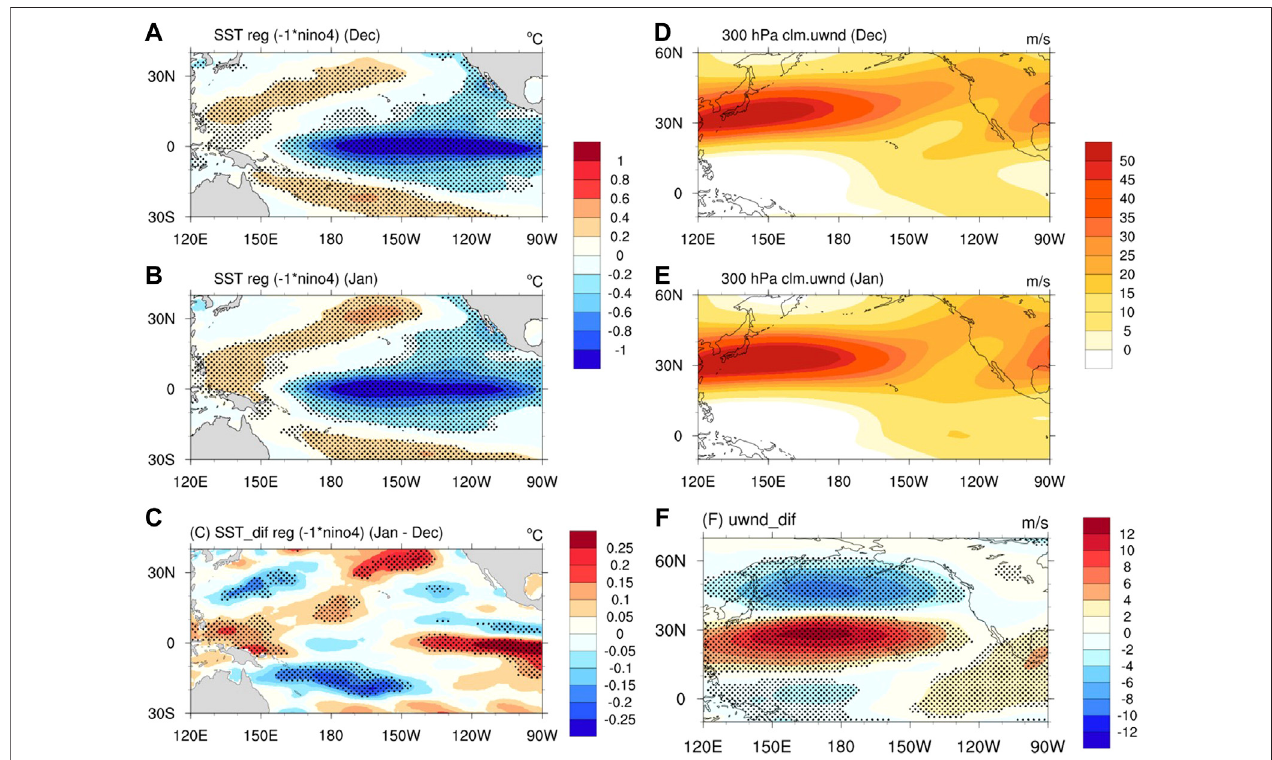
FIGURE 8 | (A) Regressions of December SST over the Paci fi c onto the − Niño4 (shading; ° C) for the period 1979 – 2017 (B) As in (A) but for January during 1980 – 2018 (C) . Regression of the SST difference between January and December over the Paci fi c onto the − Niño4 (shading; ° C) for the period 1979 – 2017 (D) Climatological December 300 hPa zonal wind (shading; m s − 1 ) for the period 1979 – 2017 (E) As in (D) but for January (F) Difference in the climatological 300 hPa zonal wind between January and December (shading; m s − 1 ) for the period 1979 – 2017. Anomalies signi fi cant at the 95% con fi dence level are denoted by dots, as estimated by the Student ’ s t-